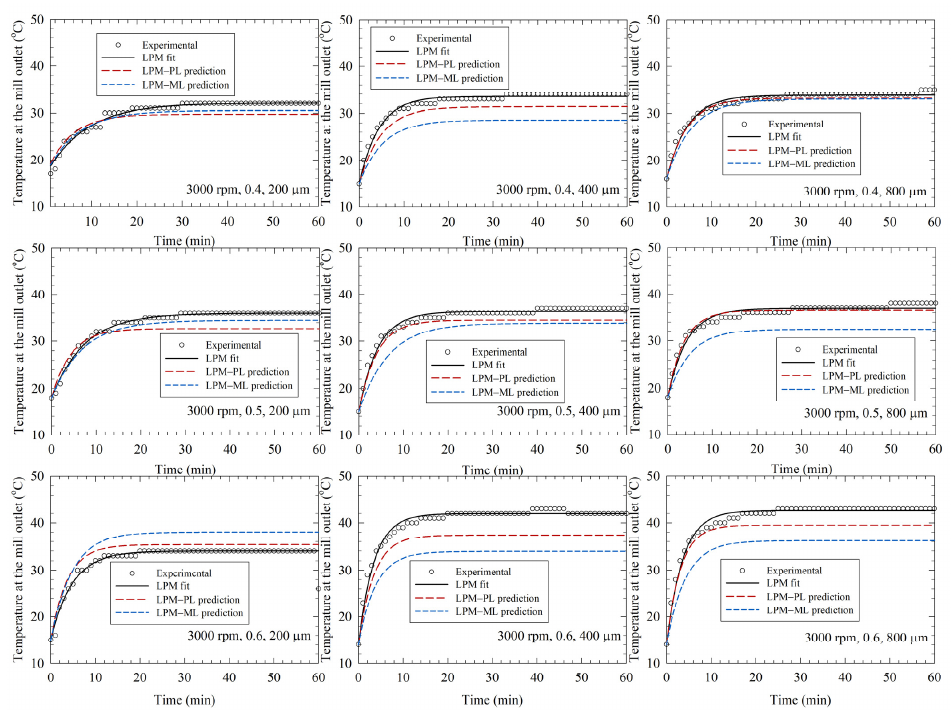
Figure 4. Experimental temperature profiles, direct fits by the lumped parameter model (LPM), and predictions by the LPM coupled with a power law (PL) model and a machine learning (ML) model. ( Left )-to-( right ): increasing bead size, ( top )-to-( bottom ): increasing bead loading, stirrer speed: 3000 rpm.